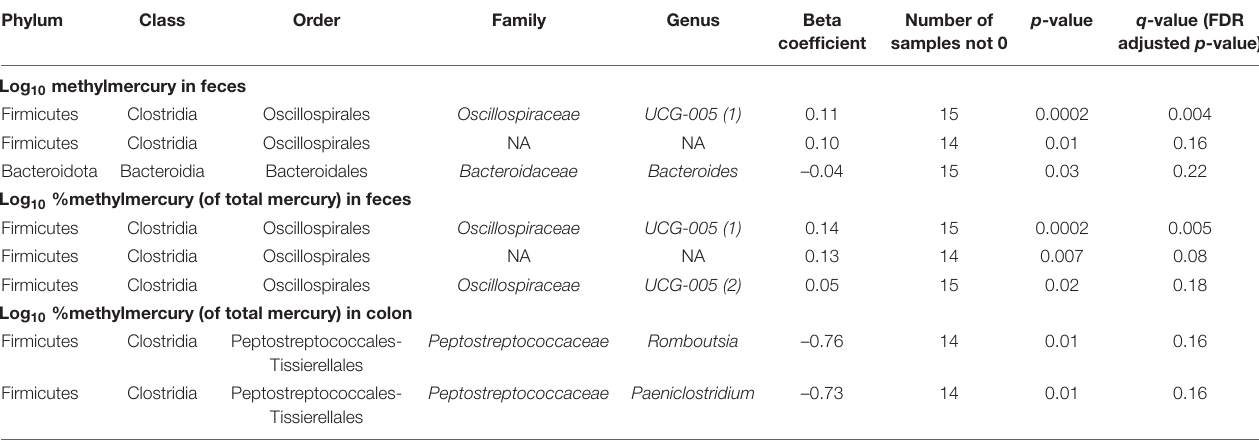
TABLE 4 | Associations between mercury species (log 10 -transformed) and gut microbiota amplicon sequence variants (arcsine-square root transformed) using Microbiome Multivariable Association with Linear Models (Maaslin2) ( n = 16 walruses).